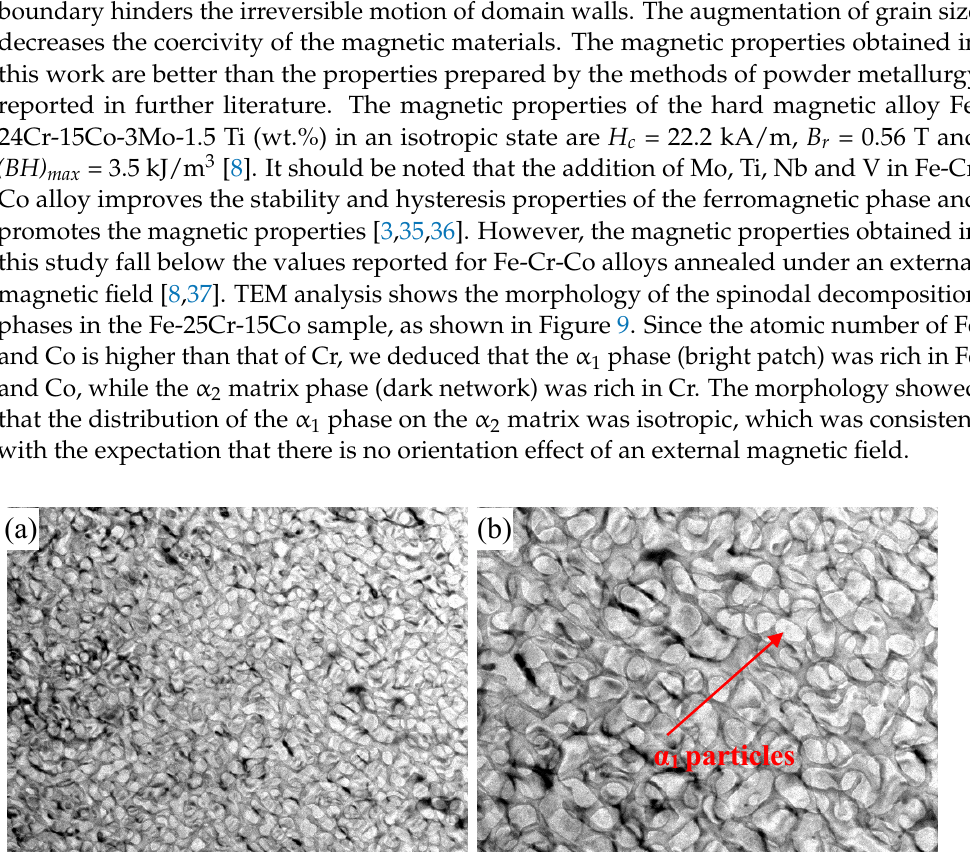
Figure 8. ( a ) Magnetic hysteresis loops (M-H) and ( b ) demagnetization curves (B-H) of Fe-25Cr- 15Co alloys under different thermal treatments. Table 2. The magnetic properties of Fe-25Cr-15Co alloys under different thermal treatments.